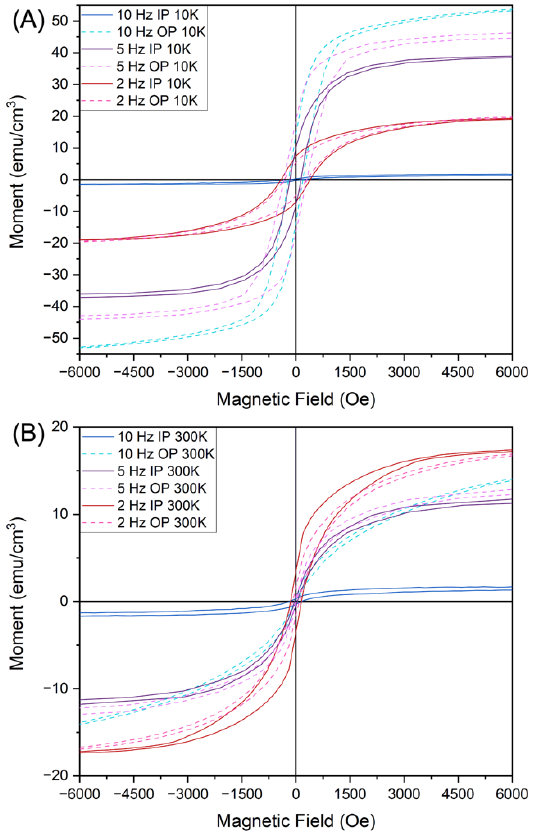
Figure 5. Magnetic hysteresis loops measured IP and OP of each sample ( A ) at 10 K and ( B ) at 300 K.